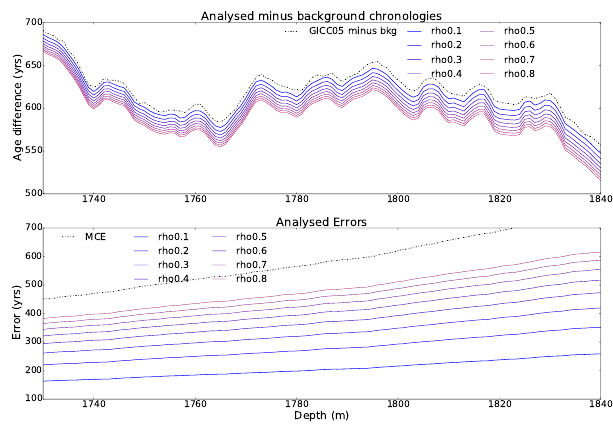
Figure 7. Sensitivity of the solution to correlation coefficient val- ues applied between duration constraints (finite depth range case). Top panel: GICC05 minus background chronology (black dashed line) and difference between analysed and background chronolo- gies. Bottom panel: MCE (black dashed line) and analysed er- rors (blue to pink lines). The duration constraints are correlated through a correlation function (Gaussian times triangle), the cor- relation length is 300 years. Uniform marker sampling at 80-, 100- and 200-year rates are shown with the blue to pink lines. The adap- tive sampling between 40 and 140 years is shown in brown. The MCE assumption is AddMCE (full error correlation between cy- cles). Table 2 summarizes experiment